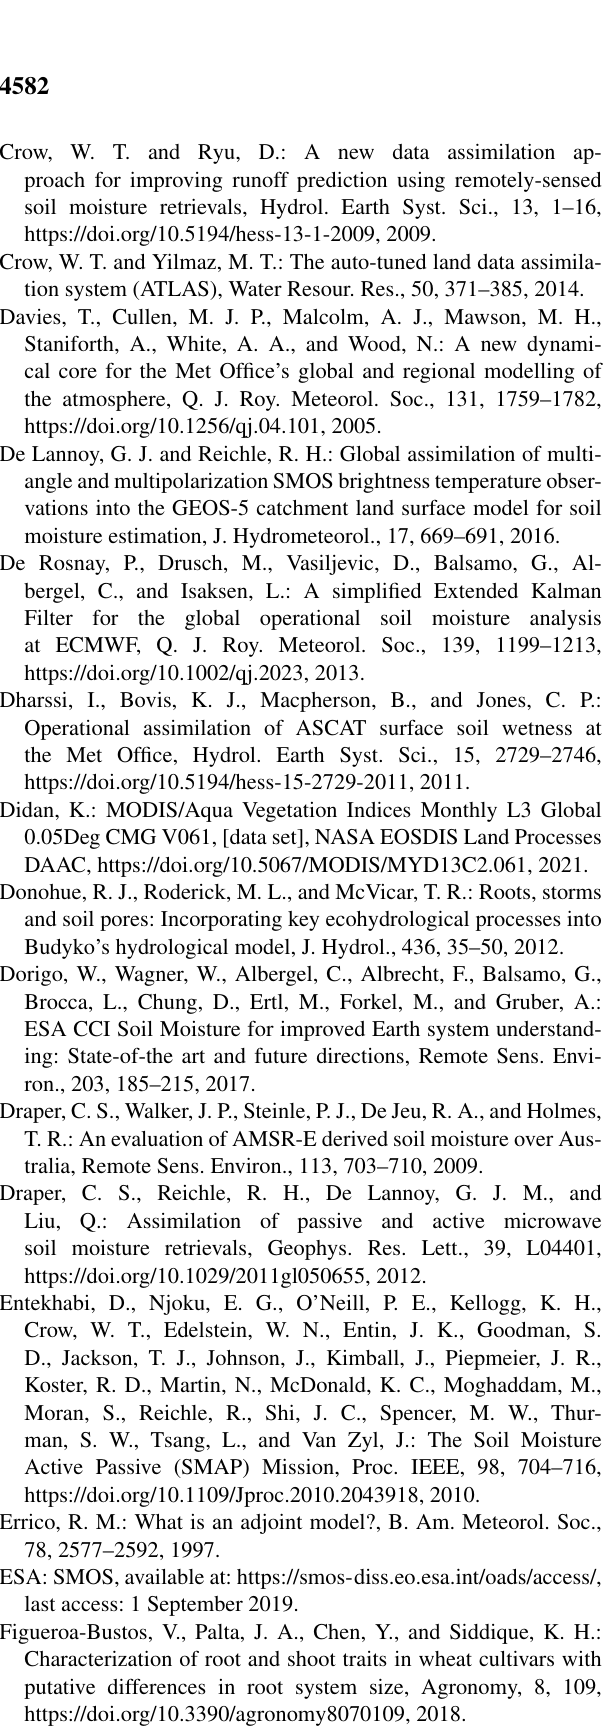
Figueroa-Bustos, V., Palta, J. A., Chen, Y., and Siddique, K. H.: Characterization of root and shoot traits in wheat cultivars with putative differences in root system size, Agronomy, 8,